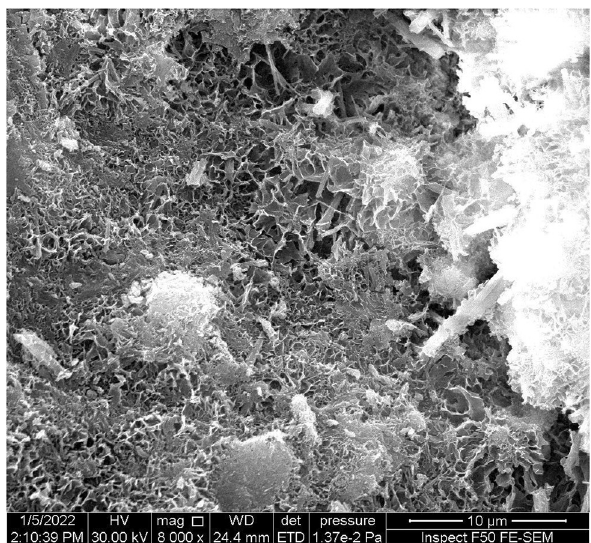
Figure 3: FESEM of sample A4 porcelanite concrete magni fi ed 8,000 × .